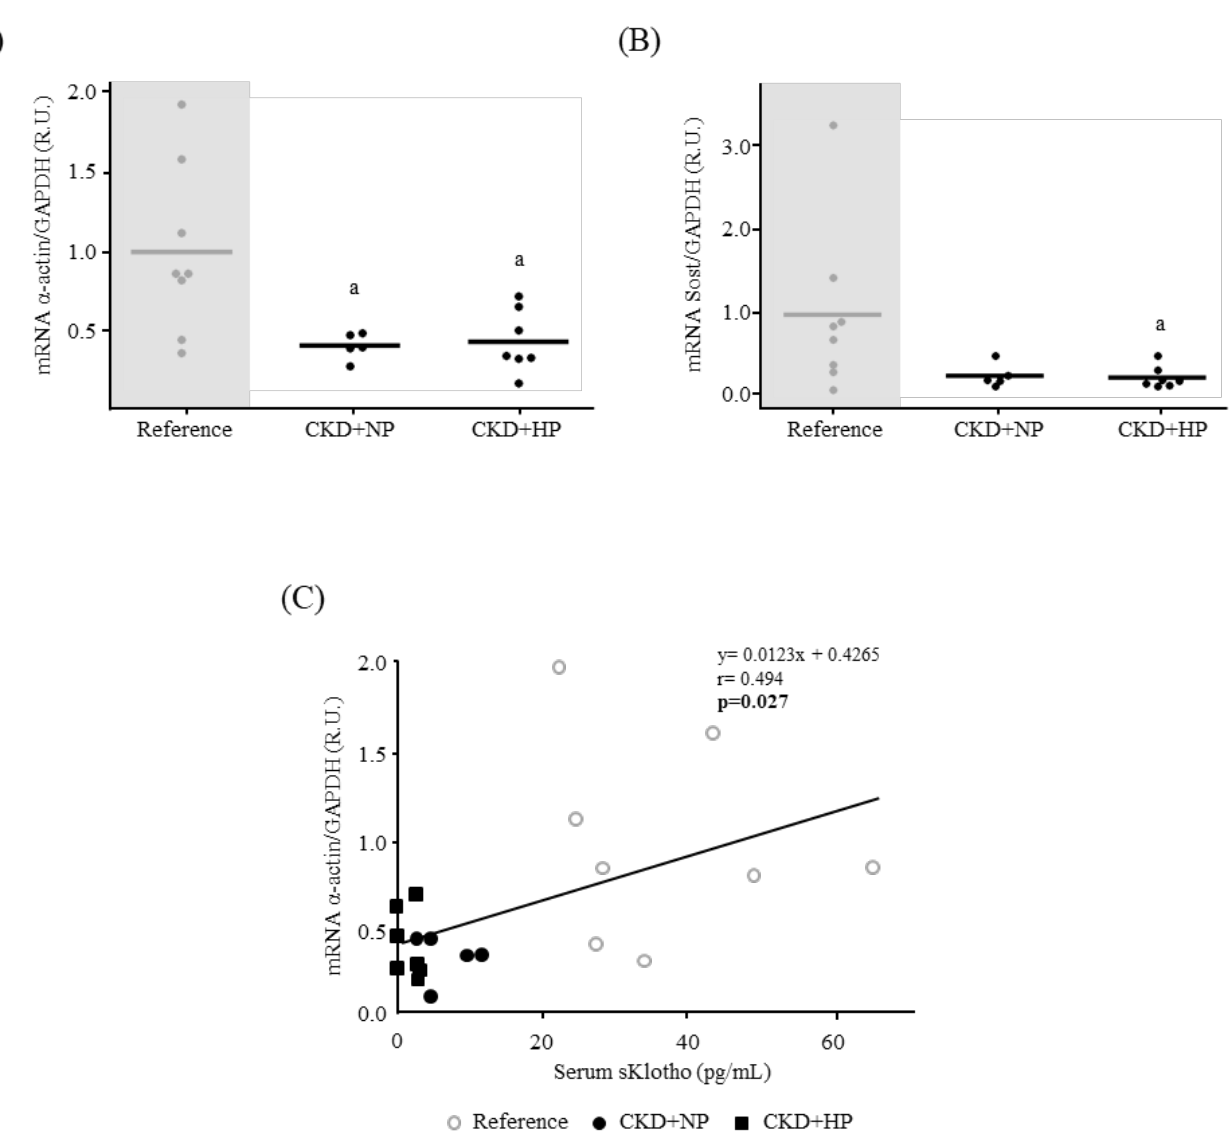
Figure 4. In vivo effects of chronic kidney disease (CKD) and dietary phosphorus intake on aortic osteogenic differentiation and components of the Wnt/ β -catenin pathway. ( A ) α -actin and ( B ) Sost mRNA levels in abdominal aortas from Sham-operated (Reference) and CKD mice fed a normal (NP) or high phosphorus (HP) diet for 14 weeks. All values are expressed relative to reference group. Mean and individual mice values are shown. a p < 0.05 vs. Reference. R.U., relative units vs. reference group. GAPDH was used as housekeeping gene. ( C ) Correlation between α -actin mRNA levels and serum sKlotho in all groups. Each shape represents Reference ( ○ ), CRF+NP (●) and CRF+HP ( ■ ) values.